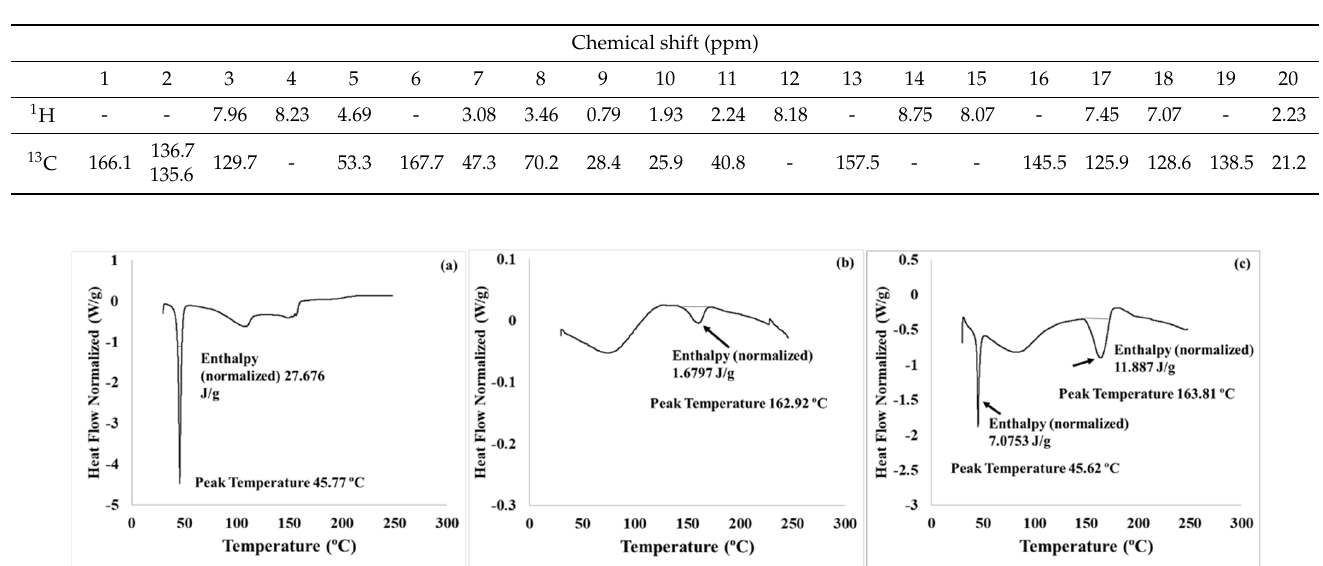
Figure 6. Differential scanning calorimetry (DSC) thermograms: ( a ) TQ powder; ( b ) the polymer; ( c ) TQ–polymer nanoparticles highlighting the enthalpy and melting points.